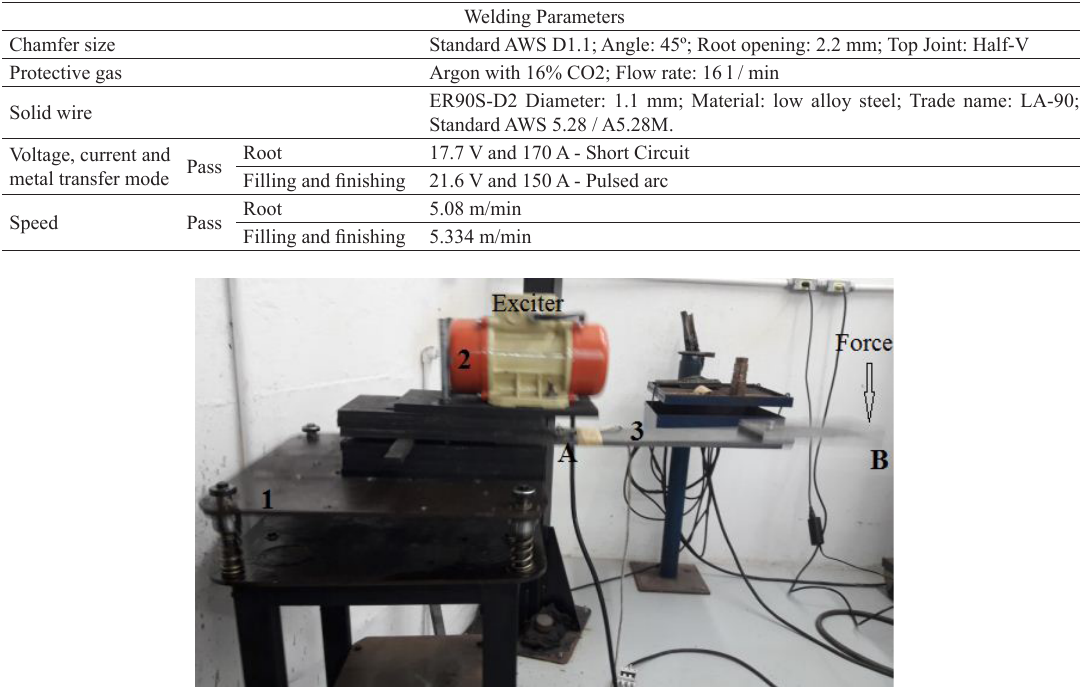
Table 3. Parameters used in MIG welding.